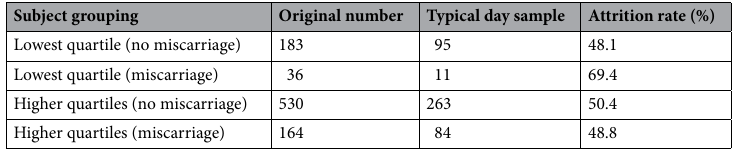
Table 1. Data from paper (with attrition rate calculated).